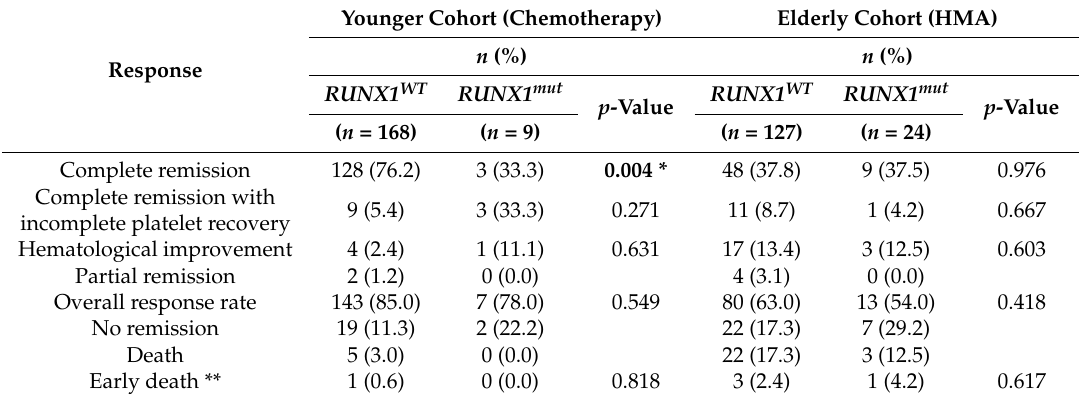
Table 2. Clinical outcomes of all patients according to age, treatment, and RUNX1 mutation status.